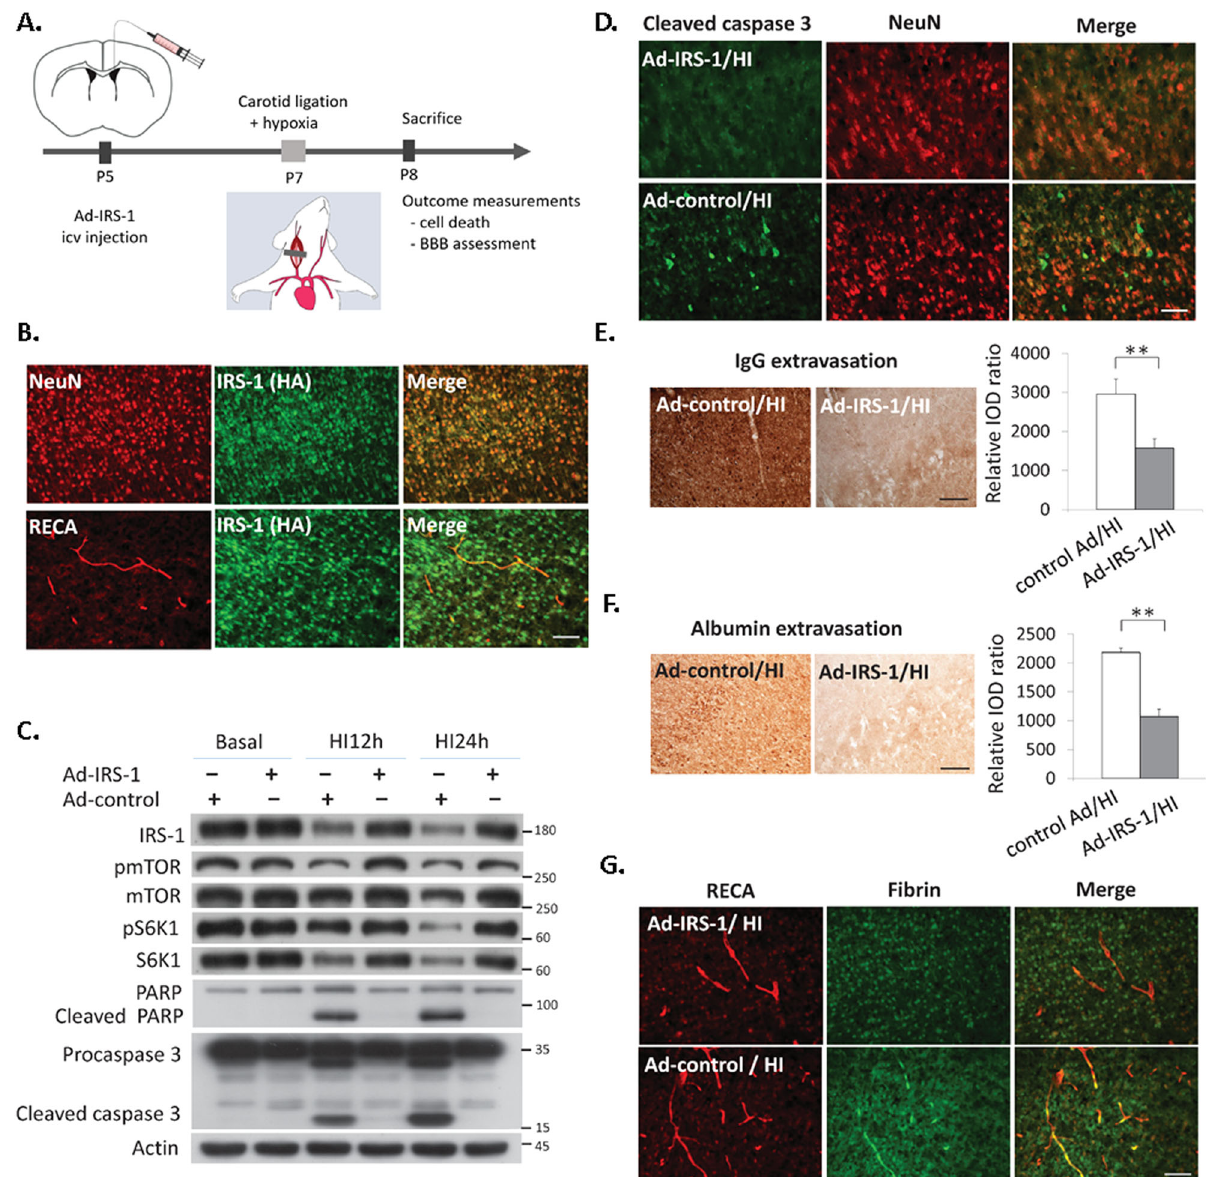
Fig. 1 Ectopic expression of IRS-1 by recombinant adenovirus-IRS-1 protected against neurovascular injury after hypoxic-ischemia. A Diagram of the experimental procedure: rat pups received intracerebroventricular (icv) injection of recombinant adenovirus IRS-1 (Ad-IRS-1) or control adenovirus (Ad-control) on postnatal (P) day 5, had hypoxic-ischemic (HI) brain injury on P7, and scari fi ed at 24 h after HI for outcome measurements. B Expression of HA-tagged IRS-1 mediated by Ad-IRS-1 on NeuN ( + ) neurons and RECA( + ) endothelium cells in the cerebral cortex of P7 rat pups. N = 4, Scale bar: 50 μ m. C The Ad-IRS-1-treated rats showed upregulate the expression of IRS-1 in the brain, and reduced cleaved-PARP, and – capsease 3 after HI compared to the Ad-control treated rats. N = 5. D The expression of cleaved caspases-3 in NeuN ( + ) neurons was obvious in the Ad-control-infected rats at 24 h after HI compared to the Ad-IRS-1-infectedrats. N = 4, Scale bar: 50 μ m. E , F Representative images illustrate immunoglobulin (IgG) and albumin extravasation in the cerebral cortex at 24 h after HI between the Ad- IRS-1-infected and Ad-control-infected rats, and the relative integrated optic density (IOD) of IgG ( N = 4, P = 0.001, t = 6.305) and albumin ( N = 4, P < 0.001, t = 14.644) signals was compared. Scale bar: 125 um. Independent t -test was used for statistical analysis. All data are presented as mean ± SD. ** P < 0.01. G The Ad-IRS-1 rats had more perivascular fi brin deposits than the Ad-control rats at 24 h after HI. N = 4, Scale bar: 50 μ and -caspase 3 after HI in the eWT and eTg/0 pups (Fig. 6A). Rapamycin treatment preserved the loss of tight junction Rapamycin also reduced the number of cleaved-caspase 3 ( + ) protein, attenuated BBB leakage and neuronal apoptosis, and neurons in the cortex in eTg/0 pups (Fig. 6B). Moreover, after HI, provided neuroprotection after HI in the endothelial-speci fi c the BBB leakage as evidenced by IgG and albumin extravasation IRS-1 transgenic rats was also markedly diminished in the rapamycin-treated eTg/0 Rapamycin treatment reduced levels of pmTOR and its down- pups compared to that of vehicle-treated eTg/0 pups (Fig. 6C, D). stream pS6K1 at basal state and also at 24 h after HI in the cortex The loss of the tight junction proteins, ZO-1, occludin and claudin- of the eWT and eTg/0 pups (Fig. 6A). Compared to vehicle, 5, found in vehicle-treated eWT and eTg/0 pups, was partially rapamycin treatment greatly decreased levels of the cleaved-PARP